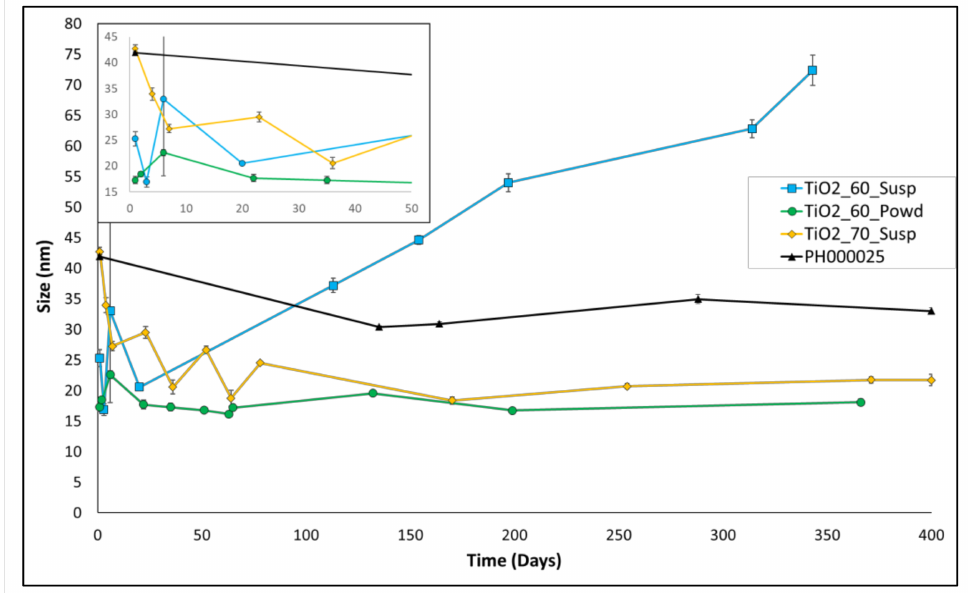
Figure 2. Long-term aging of entries 3–5 of Table 2, compared with the one of the industrial product PH000025 (entry 1 of Table 2). The detail of the first 50 days of aging is given in the